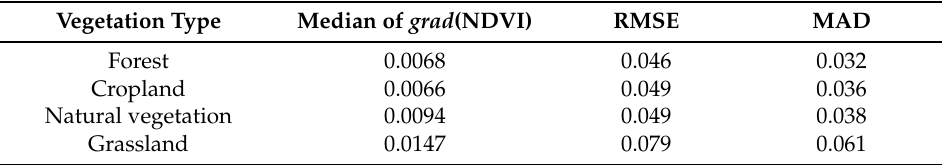
Table 6. Medians of NDVI gradients and algorithm accuracy for different vegetation